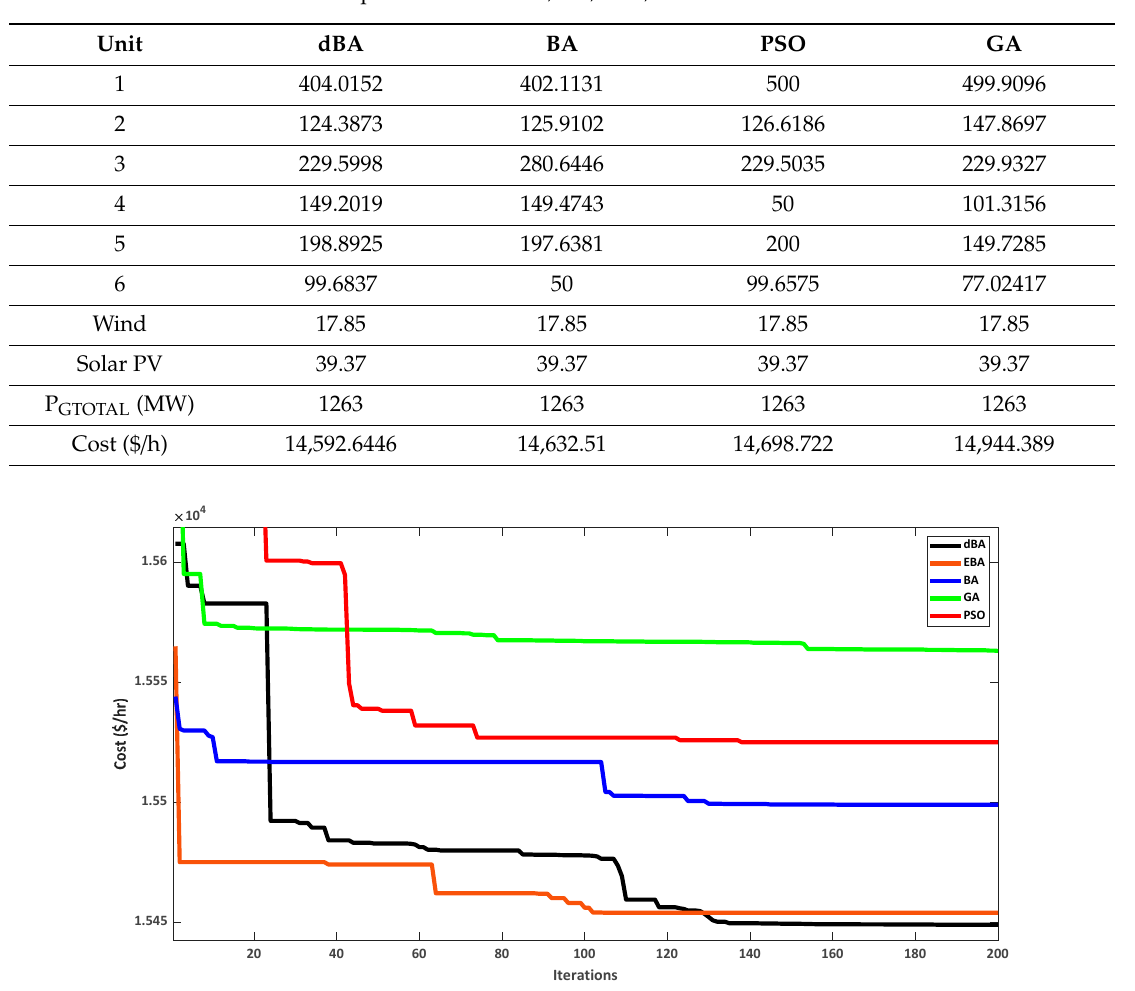
Figure 21. Cost convergence graph with the valve point effect and renewables. 4.4. Case 4 To further compare the effectiveness of the dBA with other metaheuristic techniques, in this case study, a 150 kV power system located in East Java, Indonesia, consisting of 10 units, is considered. Cost coefficients of the units with lower and upper power bounds, taken from [51], are summarized in Table 21. The total system demand without the transmission losses is 616 MW. Population size and iterations are kept the same for all the techniques to compare the results on one scale. A comparison of the results offered by the dBA and other algorithms such as the BA, GA, PSO, and modified inertial weight-based PSO (MIW-PSO) is presented in Table 22. The dBA offers a low cost, i.e., 95,633 $/h when compared to all other mentioned techniques, thus validating the workability of the dBA. This low cost is also depicted in the convergence characteristics drawn for the dBA and MIWPSO, as shown in Figure 22. For the comparison purpose, the convergence characteristics are drawn for 15 iterations.